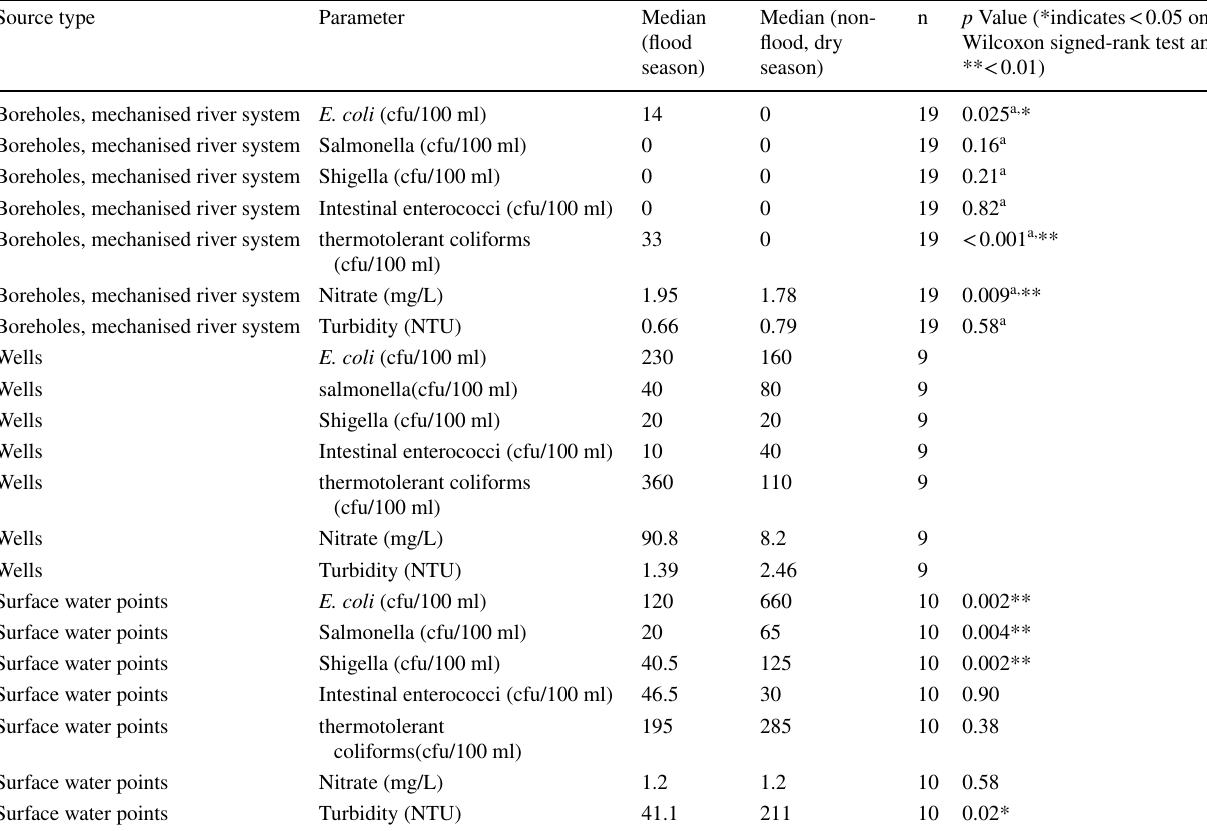
Table 2 Median microbiological contamination of 40 water points sampled in both flood and non-flood seasons in northern Ghana, showing sig- nificance of a Wilcoxon signed-rank test for seasonal distributional differences in bacteria counts